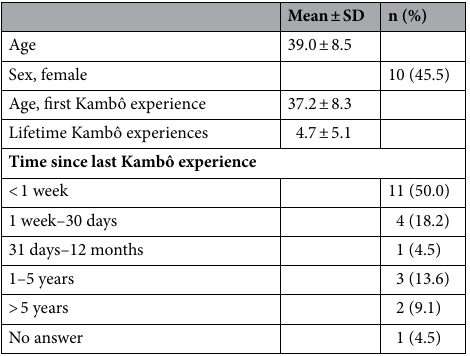
Table 1. Sample characteristics of the n = 22 participants included in the